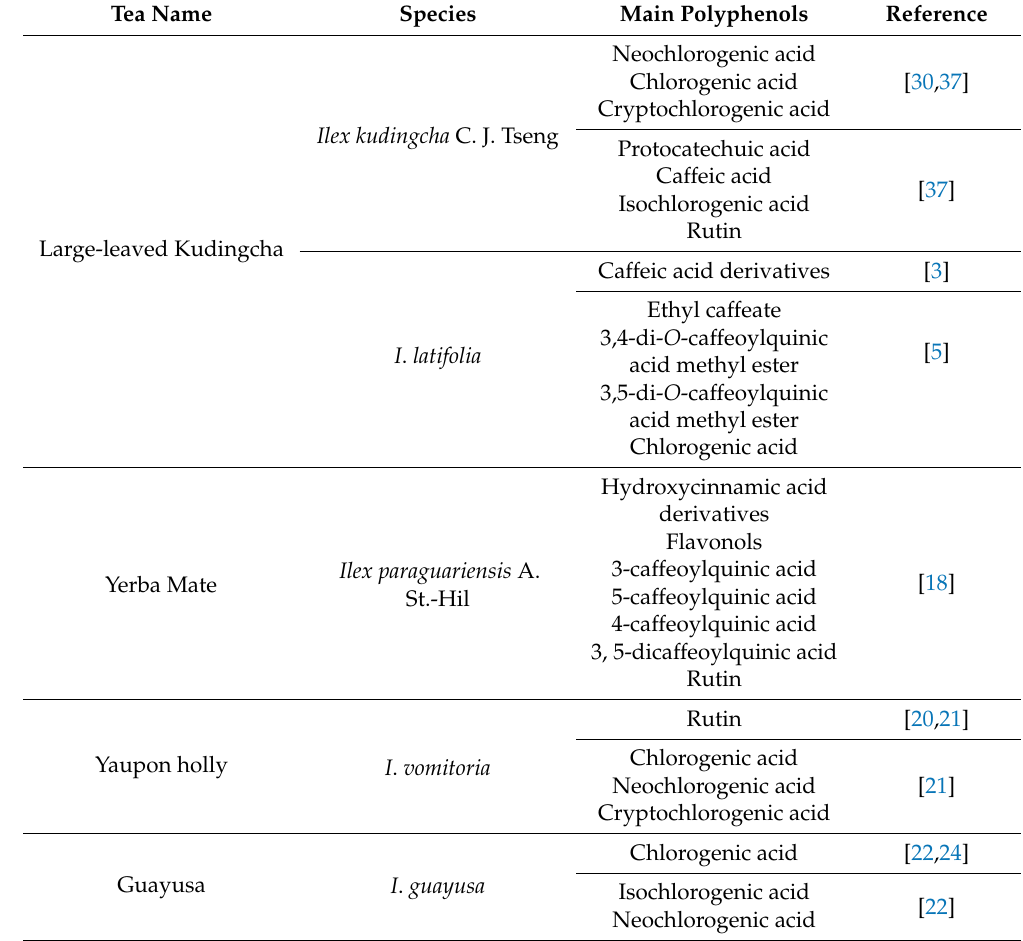
Table 2. Main phenolic compounds in the genus